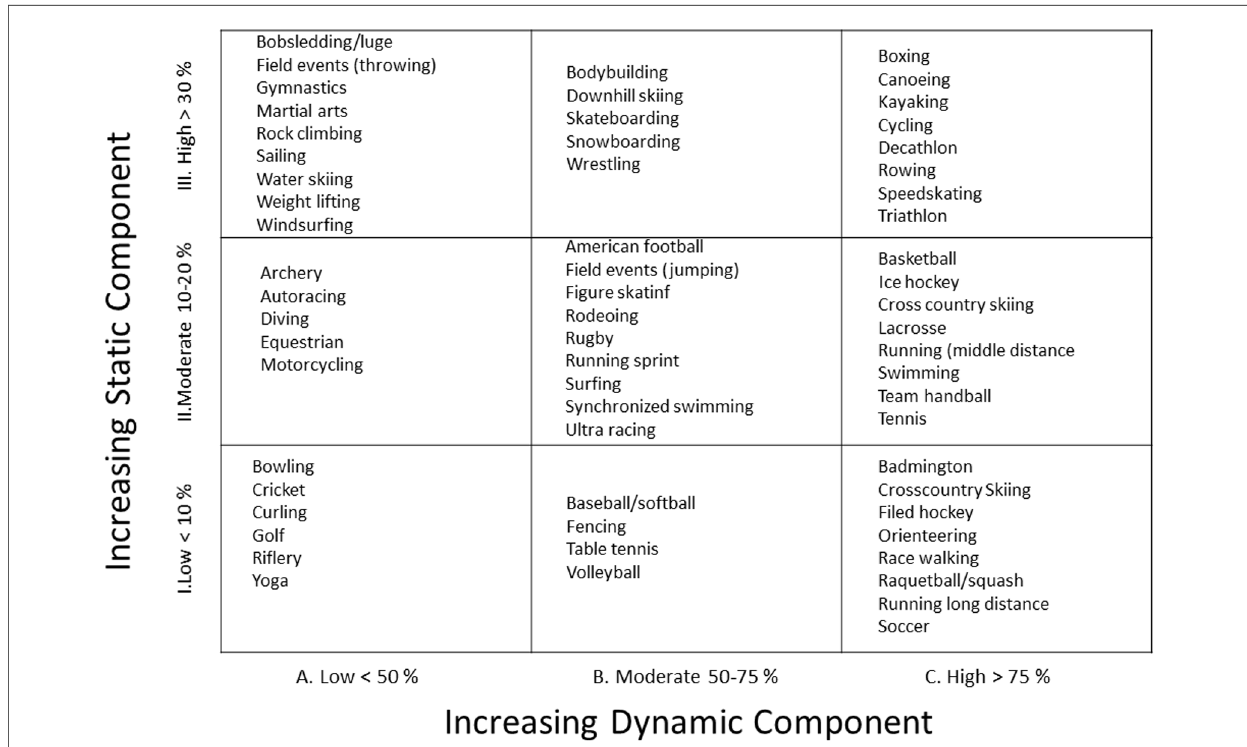
FIGURE 1 Classi fi cation sport based on peak static and dynamic component (12).